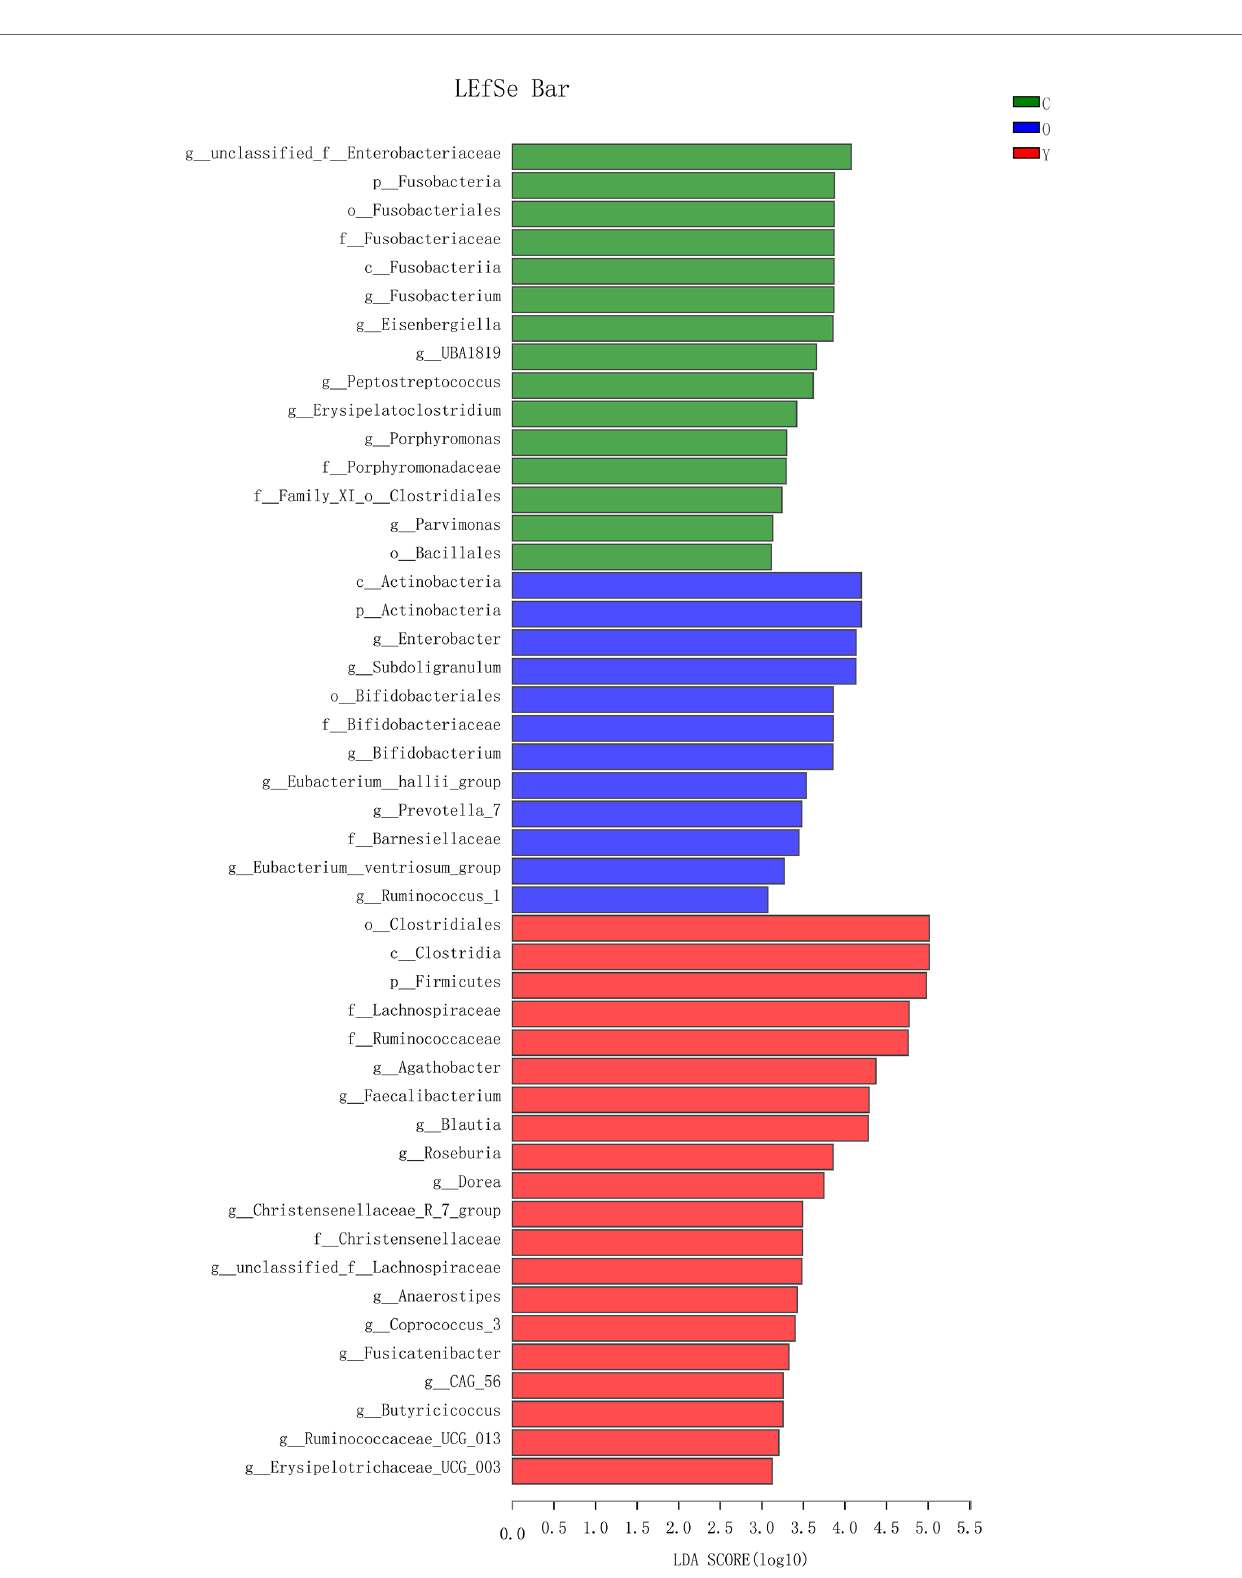
Frontiers in Cellular and Infection Microbiology |